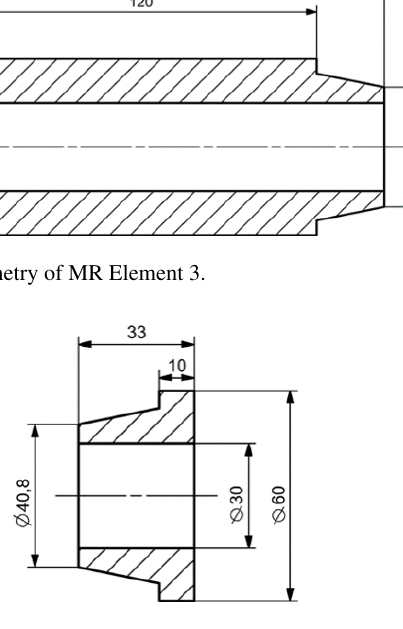
Figure 4. Geometry of MR Element 5.